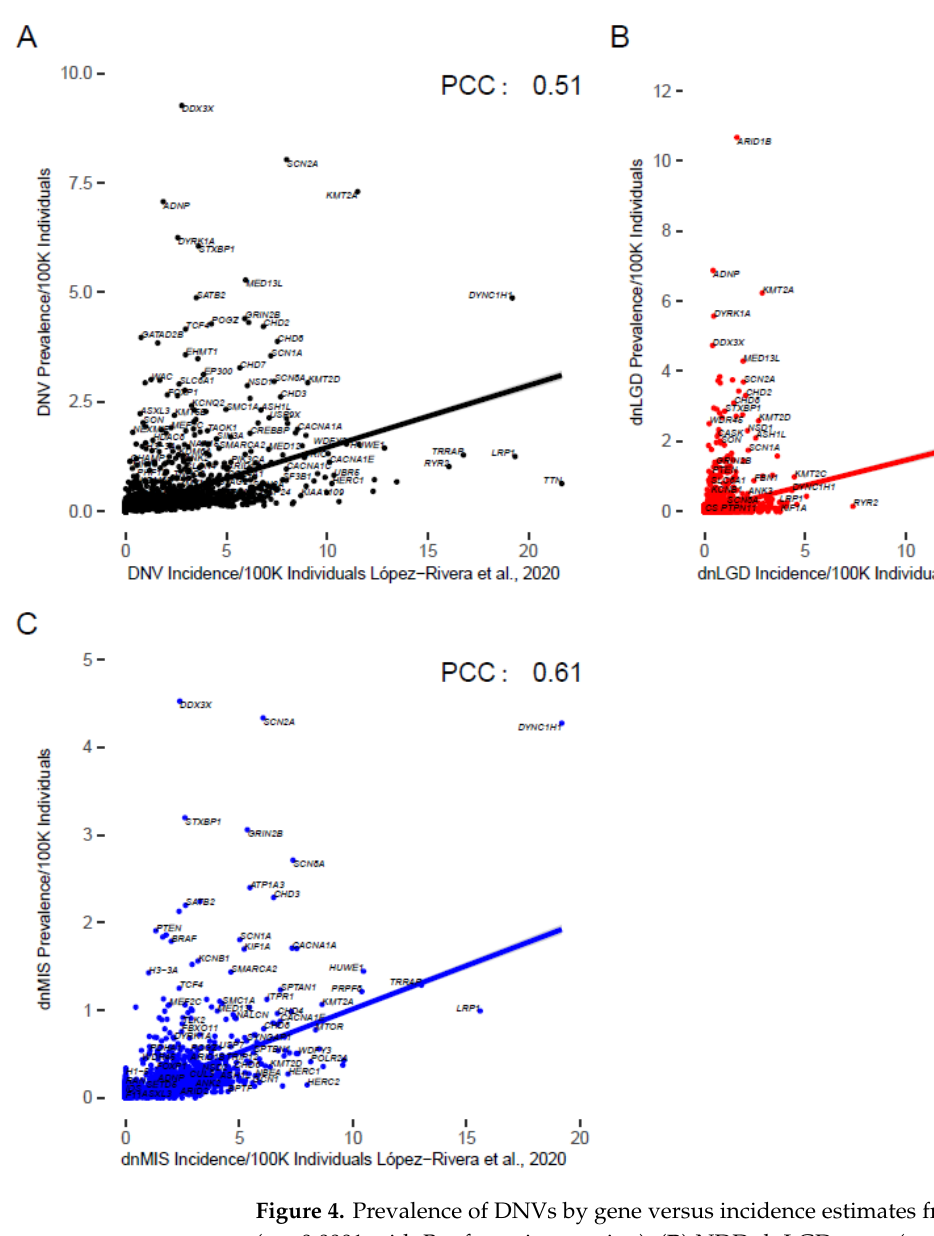
Figure 4. Prevalence of DNVs by gene versus incidence estimates from [14]. ( A ) NDD DNV cases ( p < 0.0001 with Bonferroni correction), ( B ) NDD dnLGD cases ( p < 0.0001), and ( C ) NDD dnMIS cases ( p < 0.0001). All variant types had a positive correlation with previous incidence estimates, shown with Pearson’s correlation coefficients (PCC). Notably, some genes without clinical relevance, such as TTN, are also shown. Corrected p values and confidence intervals are shown in Table S6.